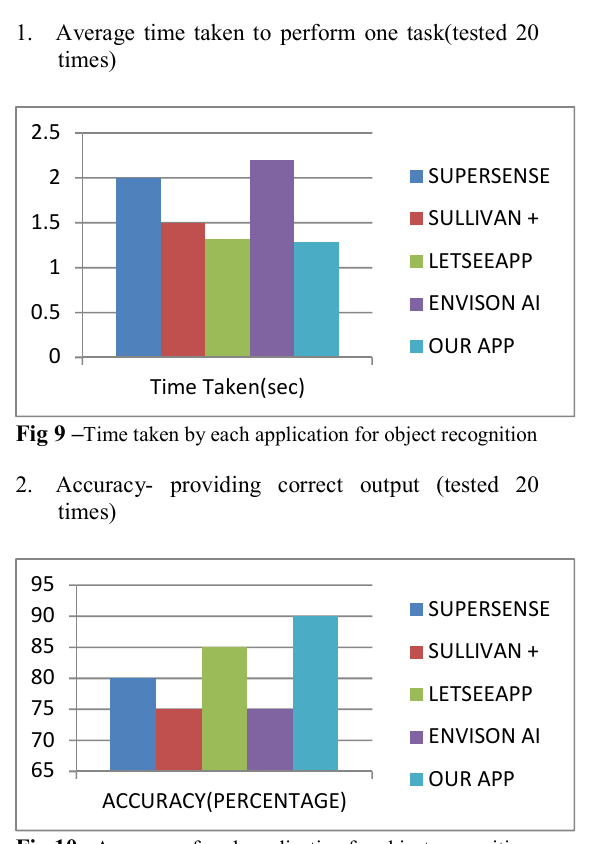
Fig 10 – Accuracy of each application for object recognition